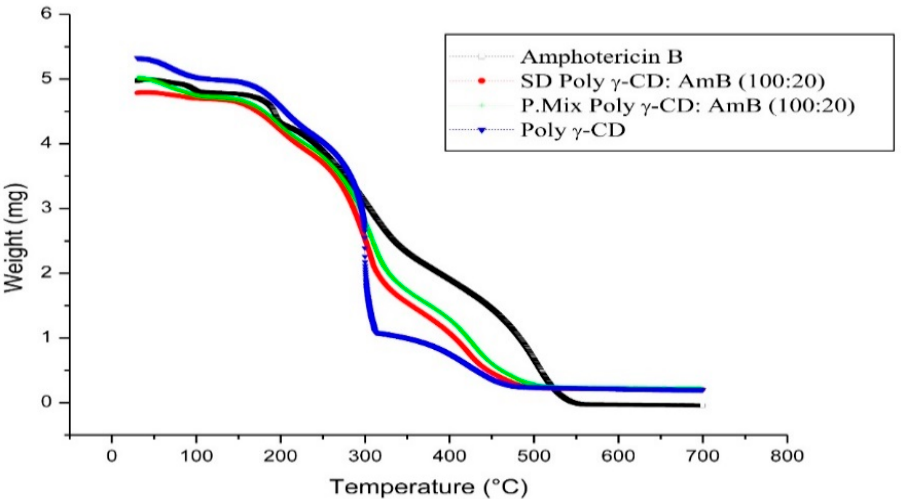
Figure 4. Thermal analysis of amphotericin B (AmB), uncharged solid dispersion of γ -cyclodextrin based polymer (Poly γ -CD), physical mixture of γ -cyclodextrin based polymer with AmB and solid dispersion based Poly γ -CD and AmB (SD Poly γ -CD/AmB).